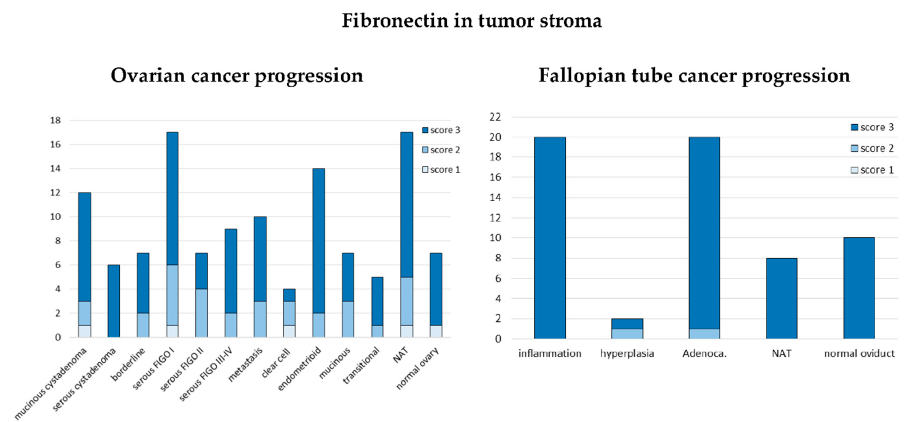
Figure 4. Expression of fibronectin in tissue arrays. The y axis represents the number of samples. NAT—normal tissue adjacent to the tumor.